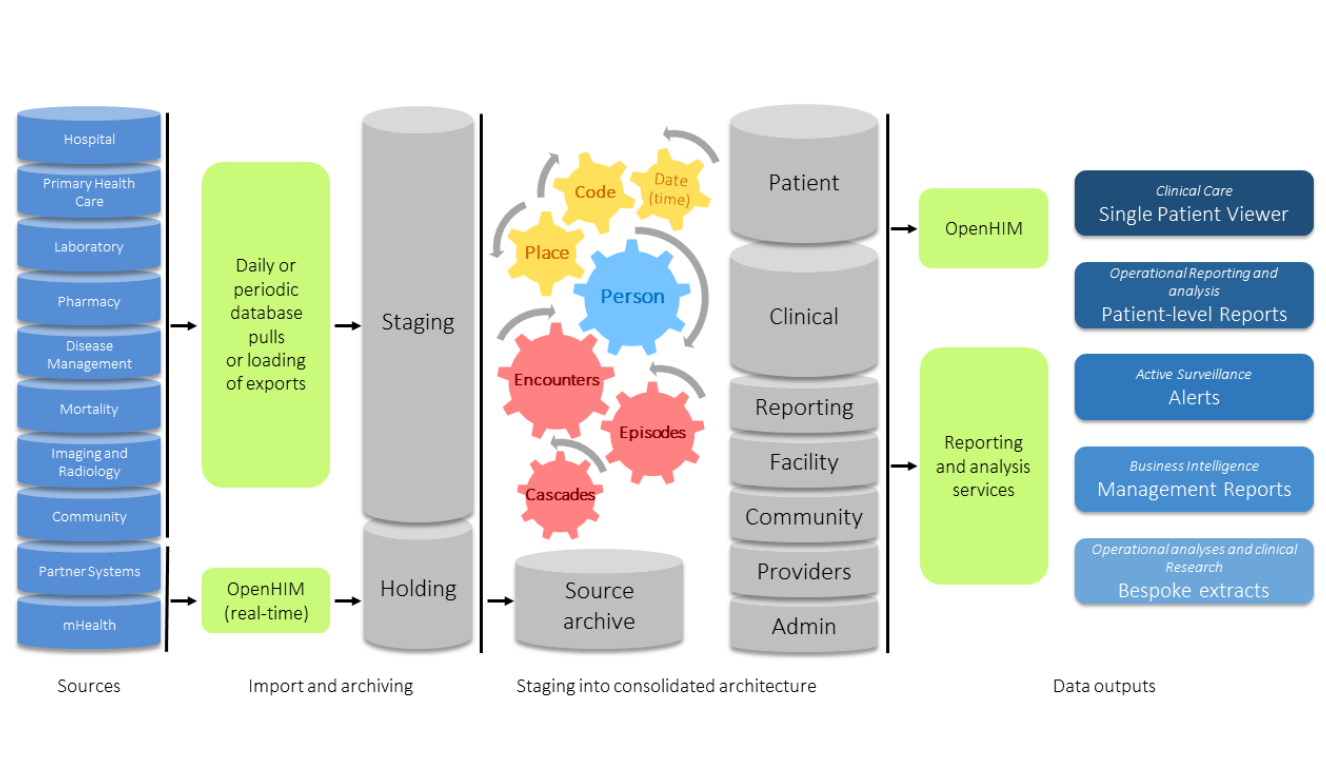
Figure 1: Western Cape Provincial Health Data Centre - high level